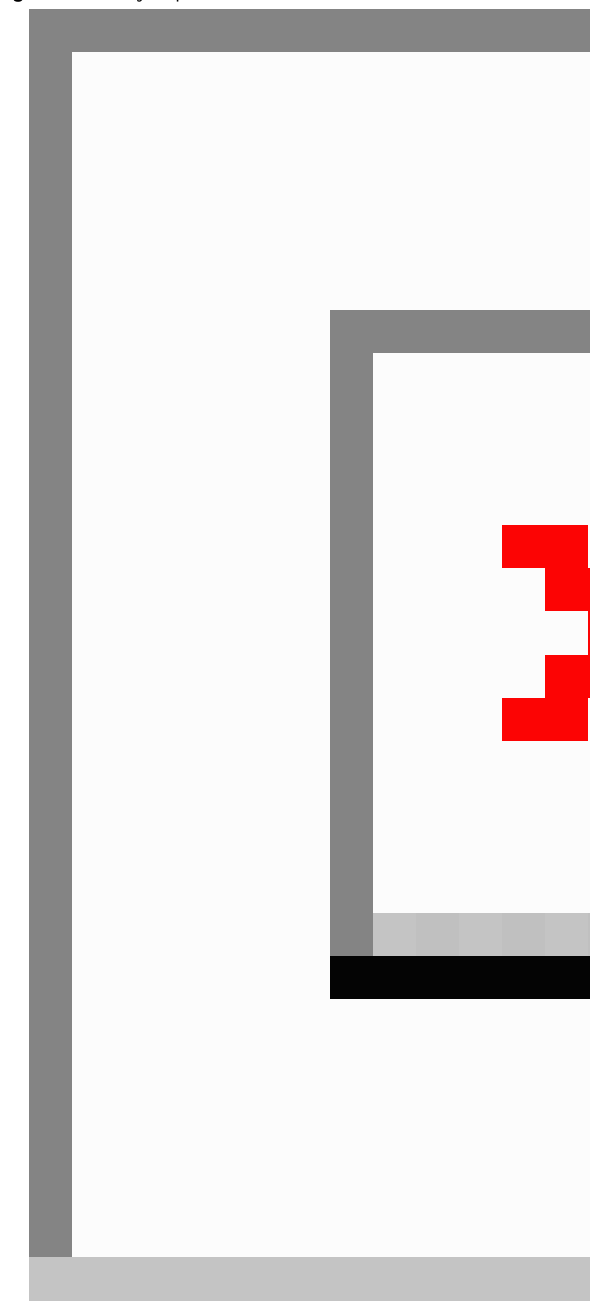
Figure 1. Theory of planned